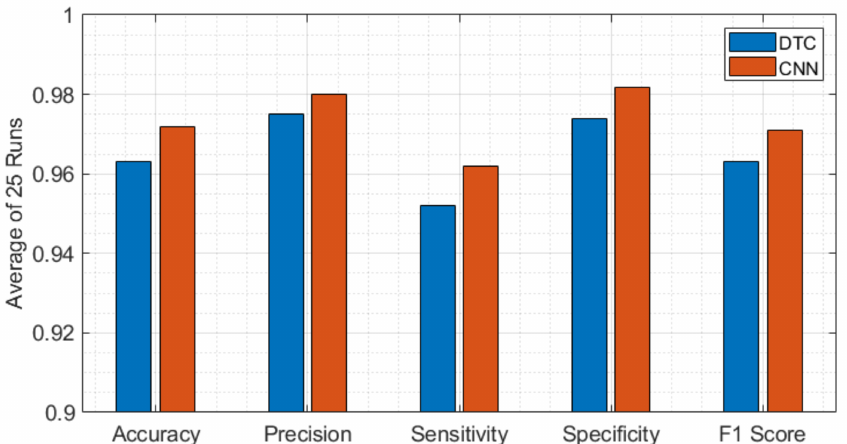
Figure 12. Performance metric comparison between DTC and CNN to diagnose SARS-CoV-2 with their best performing parameters. While the CNN algorithm outperforms the DTC algorithm in accuracy, precision, sensitivity, specificity, and F1